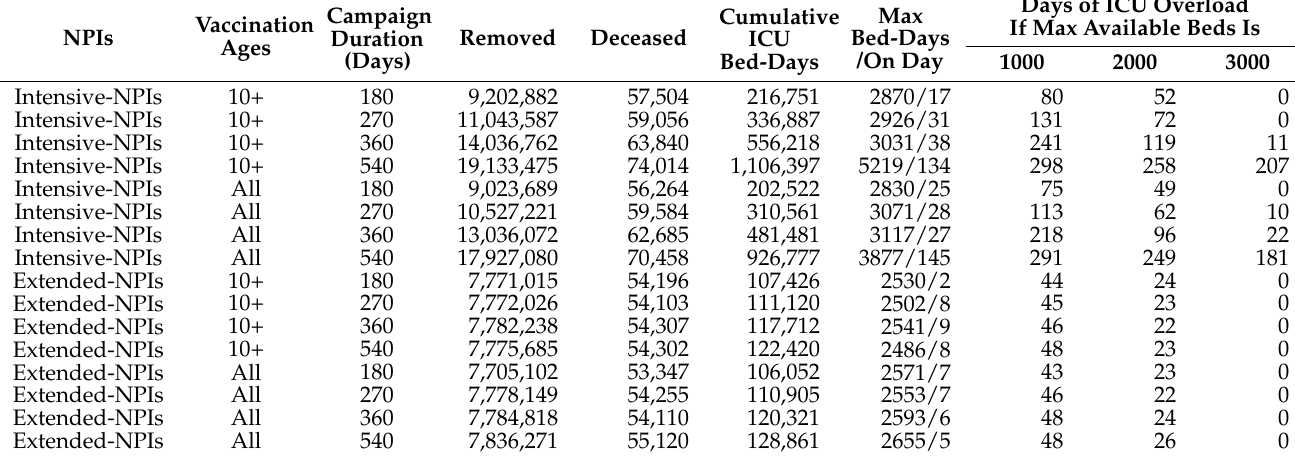
Table 5. Results of a vaccine with 50% transmission reduction, with the historical strain and Alpha variant under different vaccination ages, campaign duration, and non-pharmaceutical interventions (NPIs). Cumulative numbers of